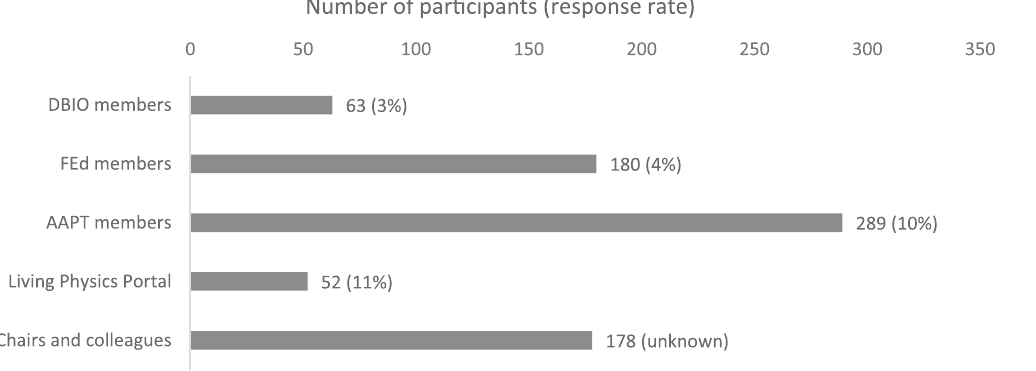
FIG. 1. Number of participants who completed the survey and response rates by distribution